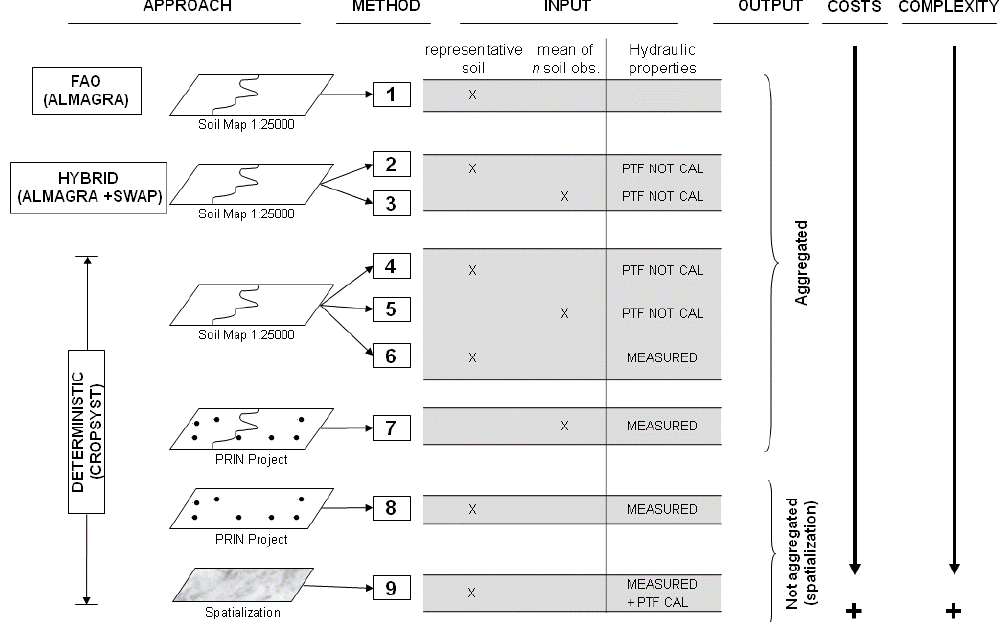
Fig. 1. Case study 1: approaches used and their main